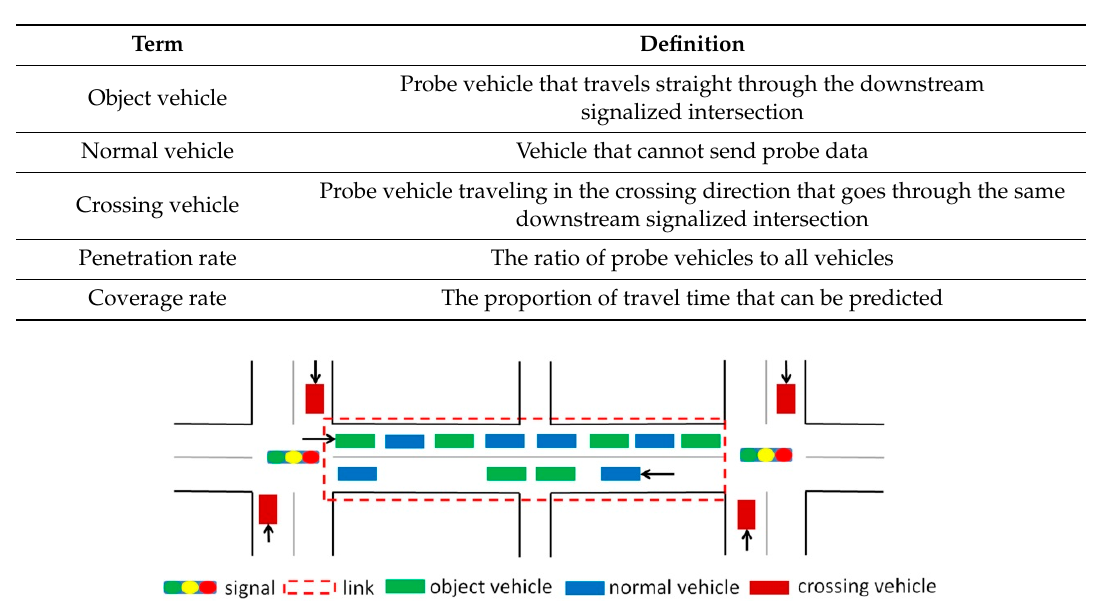
Table 1. Definition of terms related to vehicles.